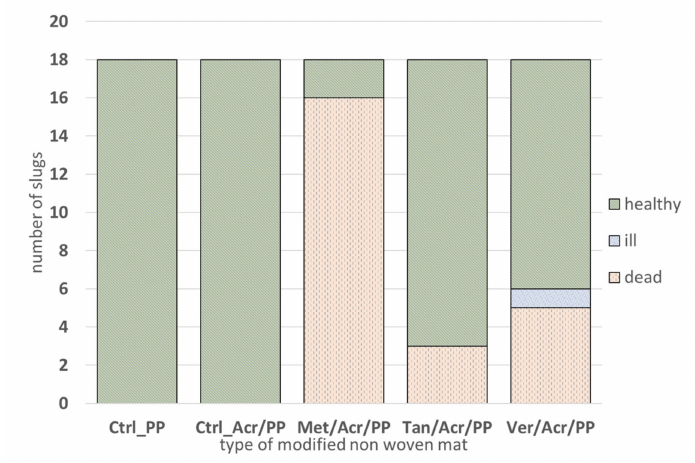
Figure 8. Number of healthy, ill, and dead D. reticulatum after seven days of observation on control and modified non-woven mats. Tukey’s test was conducted at a significance level of α =